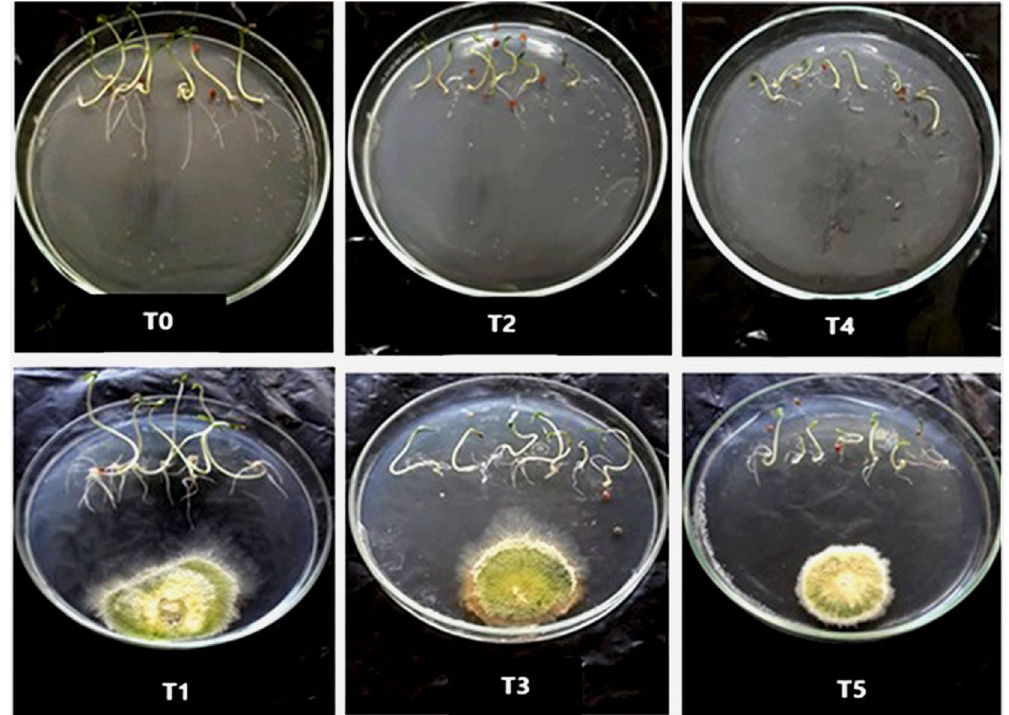
Fig. 3 The phenology of control and NaCl stressed tomato seedlings under T. viride fungal application. T 0 , T 2 and T 4 represent tomato seedlings grown on MS medium under 0, 50 and 100 mM NaCl stress, while T 1 , T 3 and T 5 represent tomato seedlings grown on MS medium with T. viride under 0, 50 and 100 mM NaCl